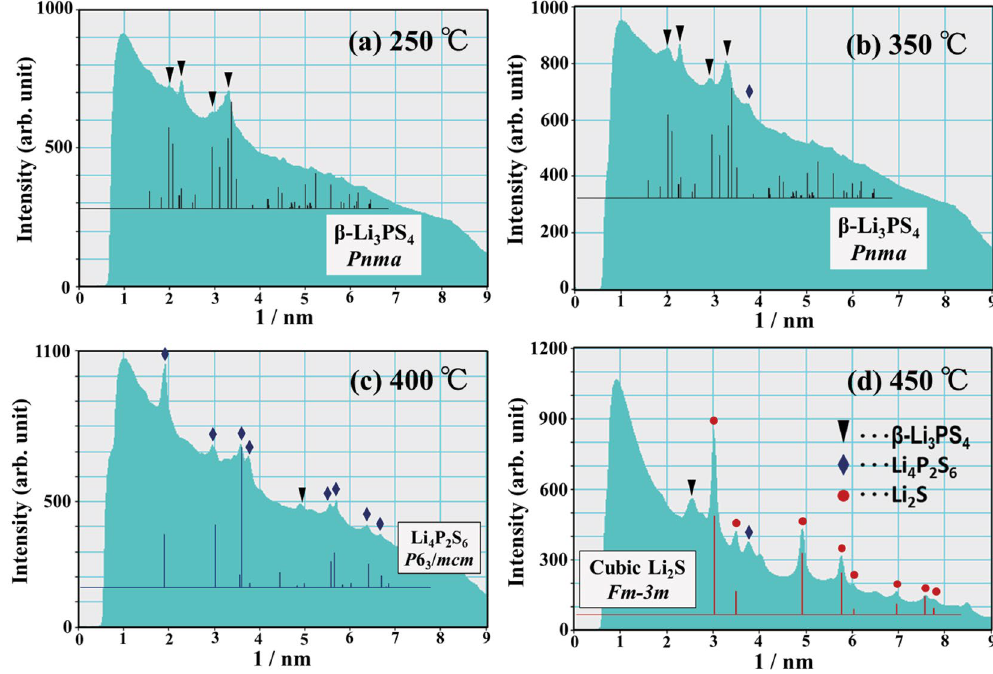
Figure 4. The intensity profiles of the ED patterns at ( a ) 250 °C, ( b ) 350 °C, ( c ) 400 °C, and ( d ) 450 °C, which were taken from the LPS region that had interfacial contact with NMC. Inverted triangles, diamonds, and circles indicate the precipitation of β -Li 3 PS 4 , Li 4 P 2 S 6 , and Li 2 S crystalline phases,